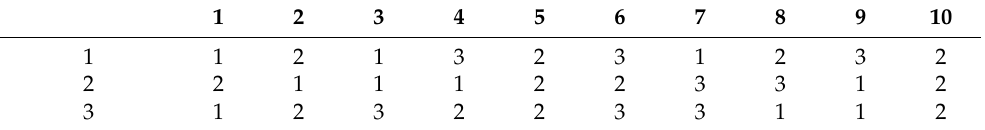
Table 14. Matrix Θ